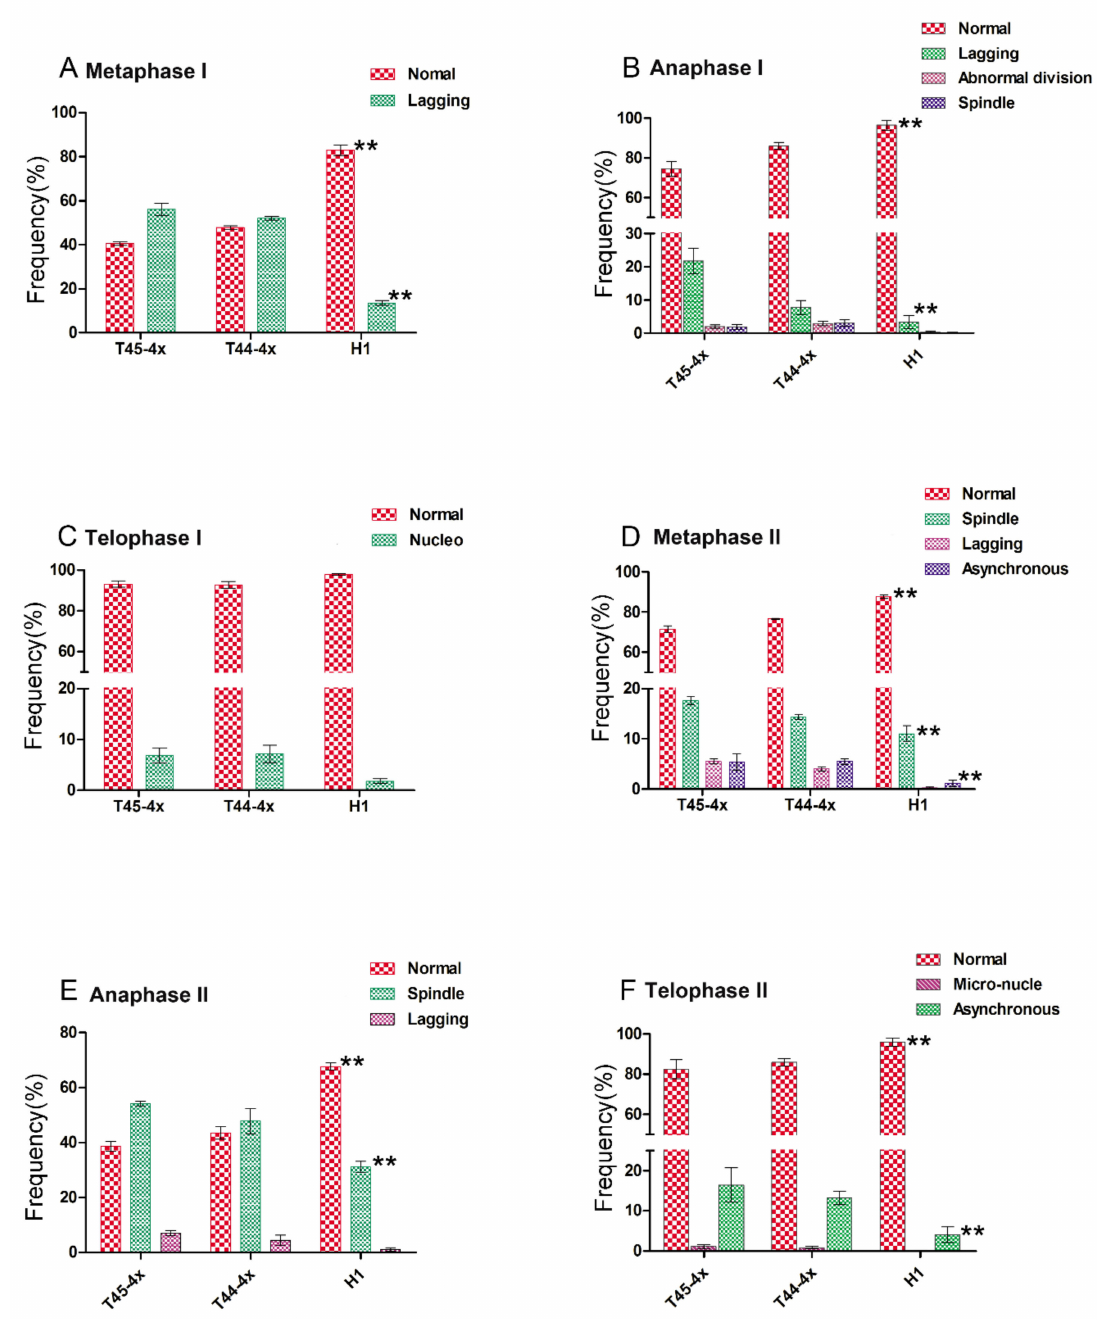
Figure 4. Frequency of PMCs in H1 compared with its parents at the meiosis stage. ( A ) Frequency of normal cells and main type of abnormal cells at Metaphase I. ( B ) Frequency of normal cells and main type of abnormal cells at Anaphase I. ( C ) Frequency of normal cells and main type of abnormal cells at Telophase I. ( D ) Frequency of normal cells and main type of abnormal cells at Metaphase II. ( E ) Frequency of normal cells and main type of abnormal cells at Anaphase II. ( F ) Frequency of normal cells and main type of abnormal cells at Telophase II. **, indicates a significant di ff erence between H1 and its two